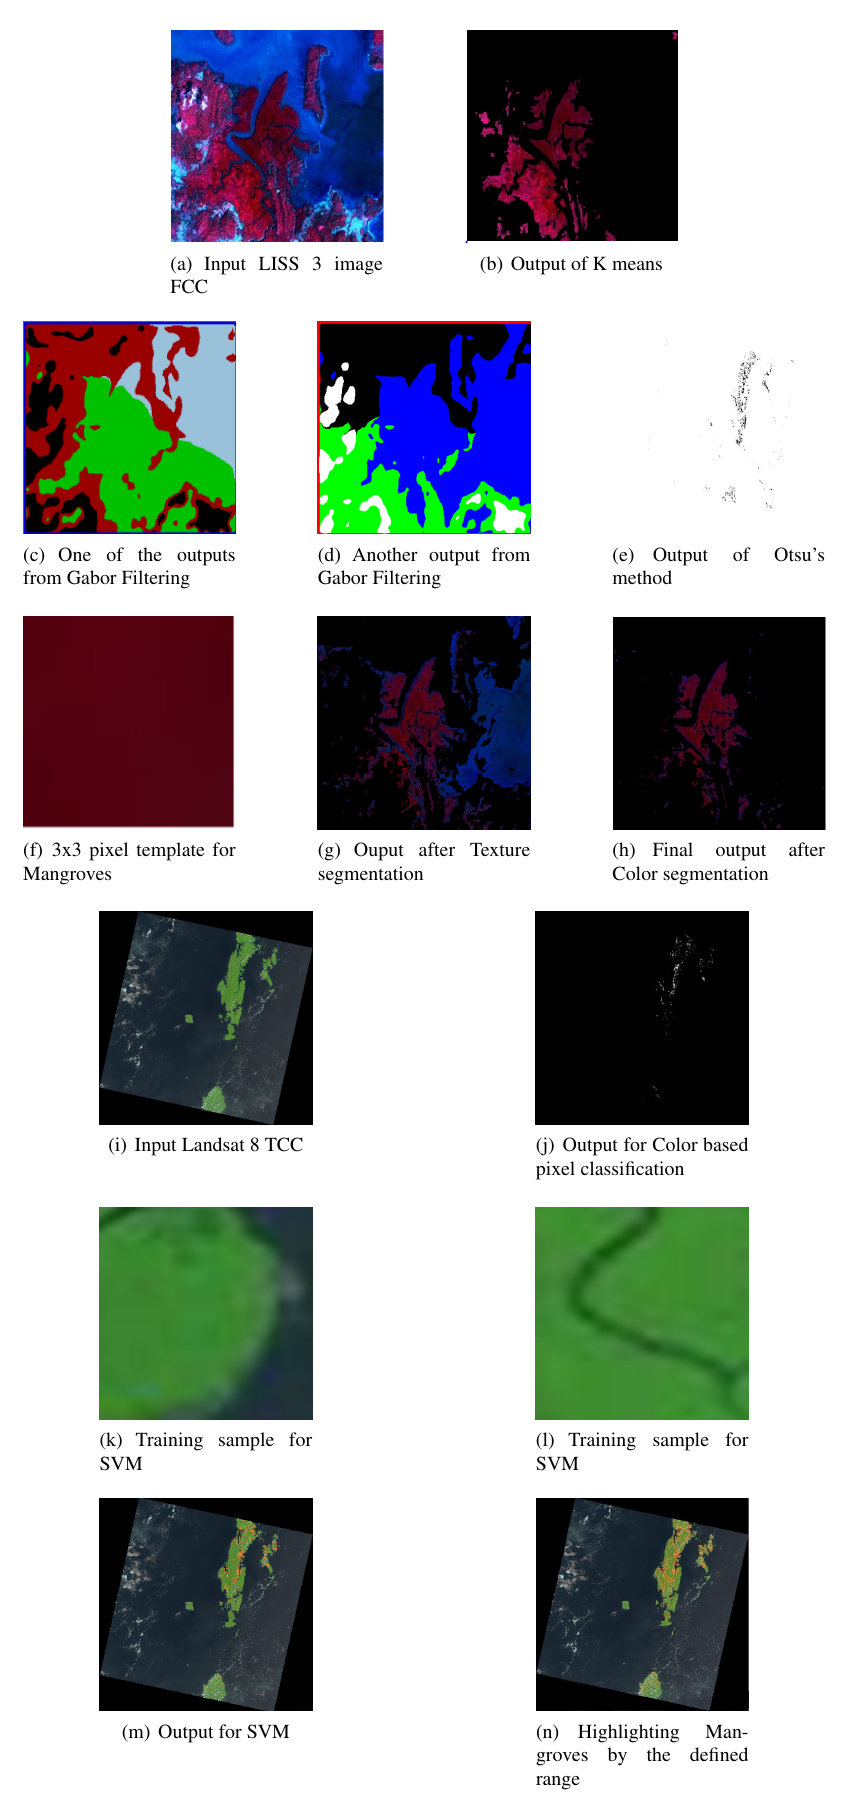
Figure 6: Input images and the results obtained in various methods